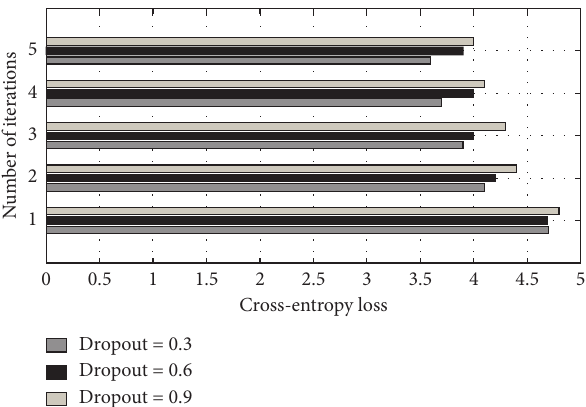
Figure 6: Comparison of cross-entropy loss under different dropouts.